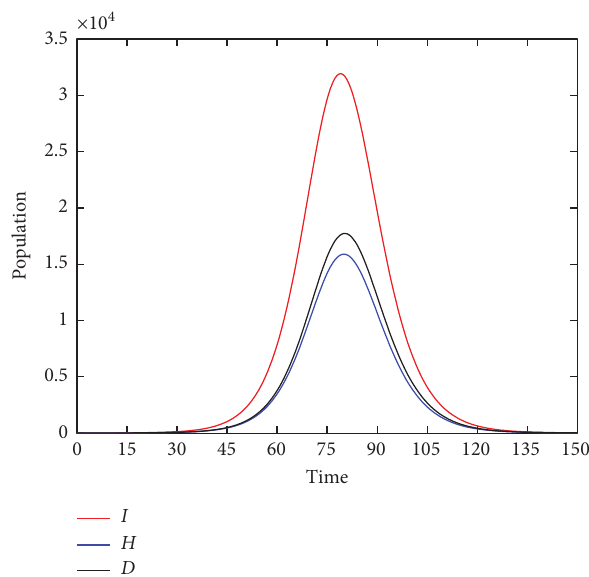
Figure 3: Simulation for the number of Dead, Hospitalized, and Symptomatic infected.